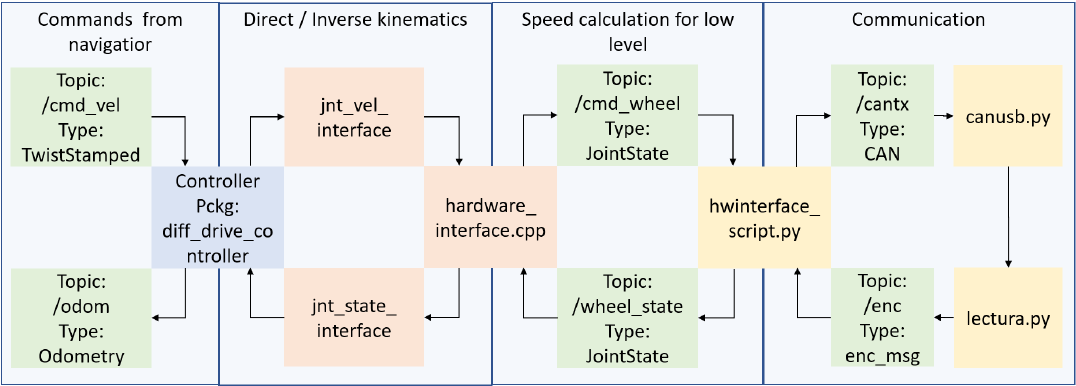
Figure 14. General scheme of high-level control.